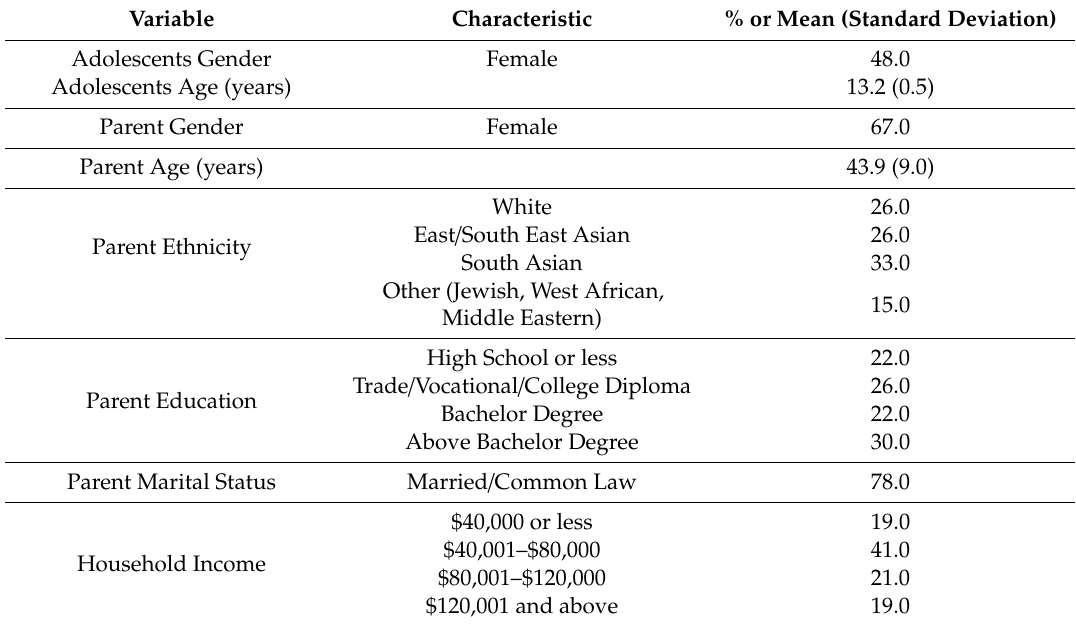
Table 1. Participant characteristics ( n = 27) 1,2